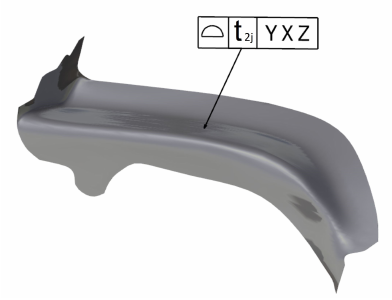
Figure 4. Tolerances of the second part.